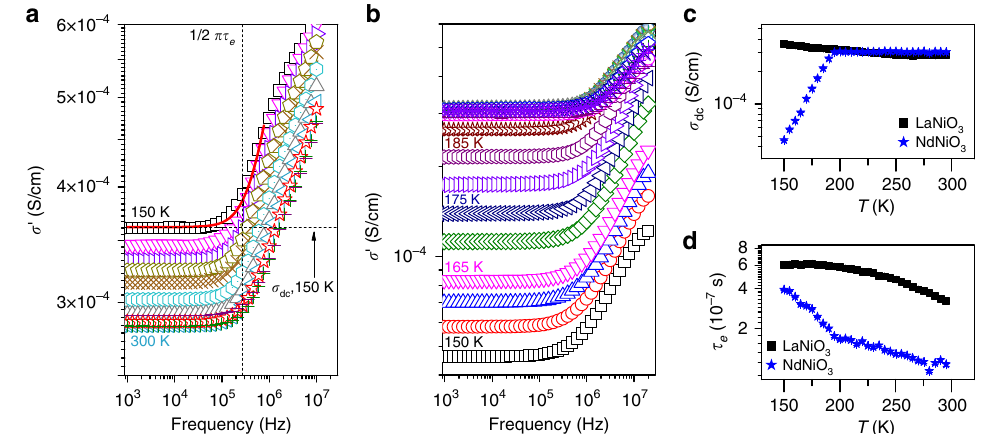
Fig. 3 Broadband dielectric spectroscopy measurements. a The frequency dependence of the real part of complex conductivity ( σ ′ ) for LaNiO 3 from 300 to 150 K. The continuous-time-random walk (CTRW) model was fi t to the spectra at all temperatures (shown as a solid red line for 150 K) to obtain values for dc conductivity (horizontal dashed line) and hopping time, τ e (vertical dashed line). b The frequency dependence of the real part of σ ′ for NdNiO 3 from 300 to 150 K. c Bulk dc conductivity of NdNiO 3 (blue stars) and LaNiO 3 (black squares) as a function of inverse temperature determined by fi tting the CTRW model to broadband dielectric spectra. d Polaronic hopping time of NdNiO 3 (blue stars) and LaNiO 3 as a function of inverse temperature determined by fi tting the CTRW model to broadband dielectric spectra